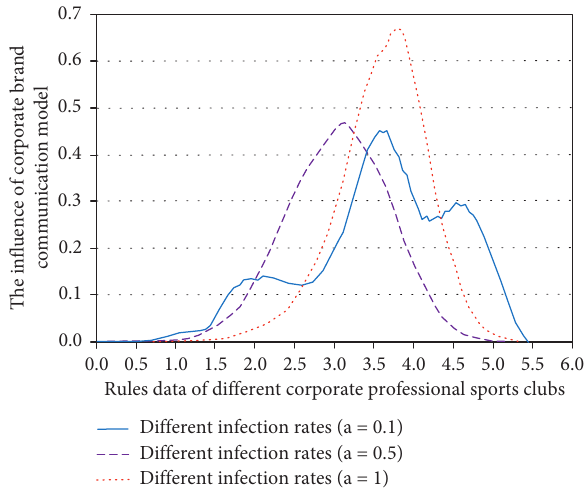
Figure 3: Simulation analysis results of the influence of corporate professional sports clubs on corporate brand communication